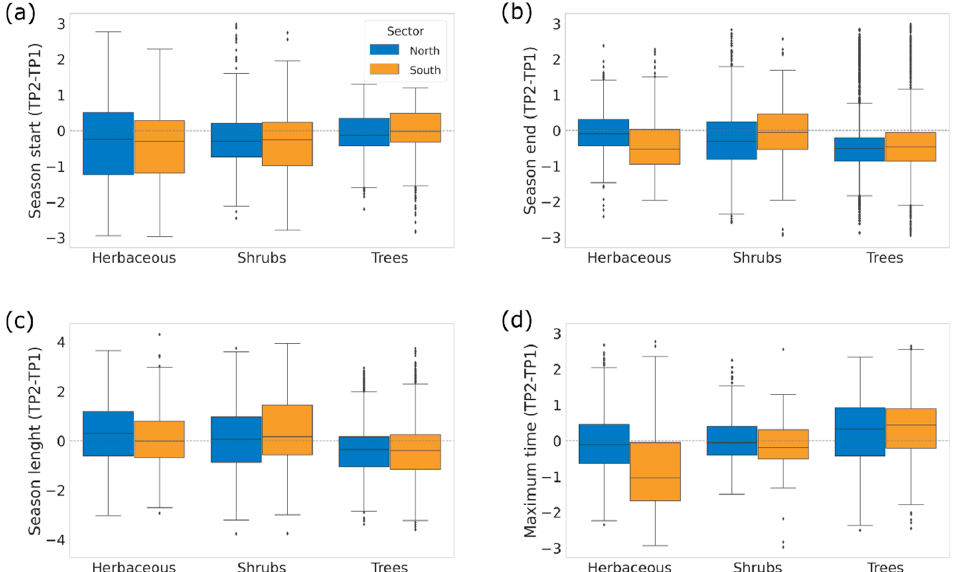
Figure 3. Distribution of differences in phenology metrics between the two study periods for the pixels in each sector (north sector in blue, south sector in brown) and for each vegetation type. Positive values indicate a delay in the season start time ( a ), maximum time ( b ), and end time ( c ), or an increase in seasonal length ( d ) from the first two seasons to the last two seasons. Negative values indicate an anticipation or decrease, values close to zero indicate little or no change. TP1—Time Period 1 (seasons 1–2), TP2—Time Period 2 (seasons 3–4).